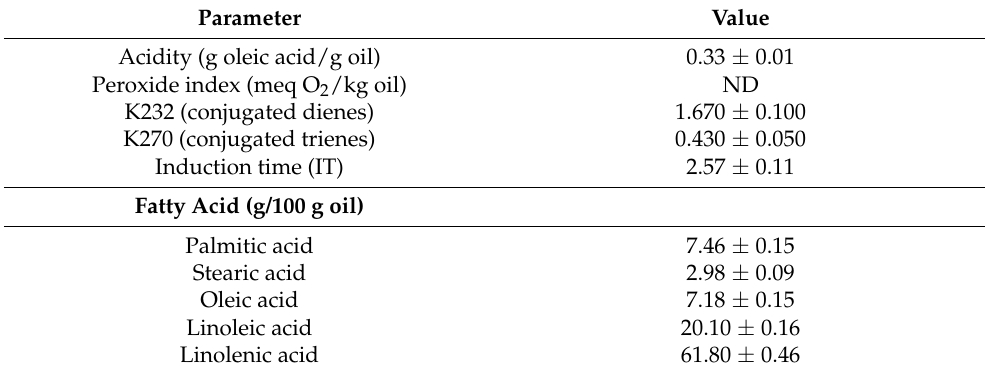
Table 5. Chia oil